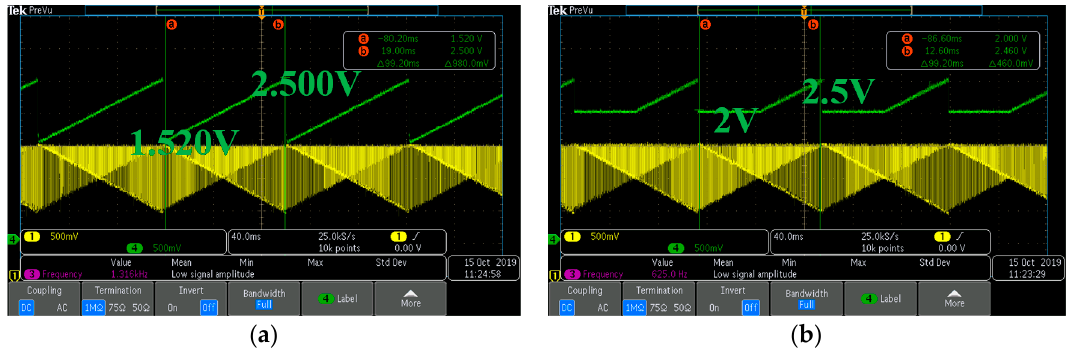
Figure 11. ( a ) Digital-to-analog converter (DAC) signal for the test mode. ( b ) Weight values of the 1st layer of the CNN.